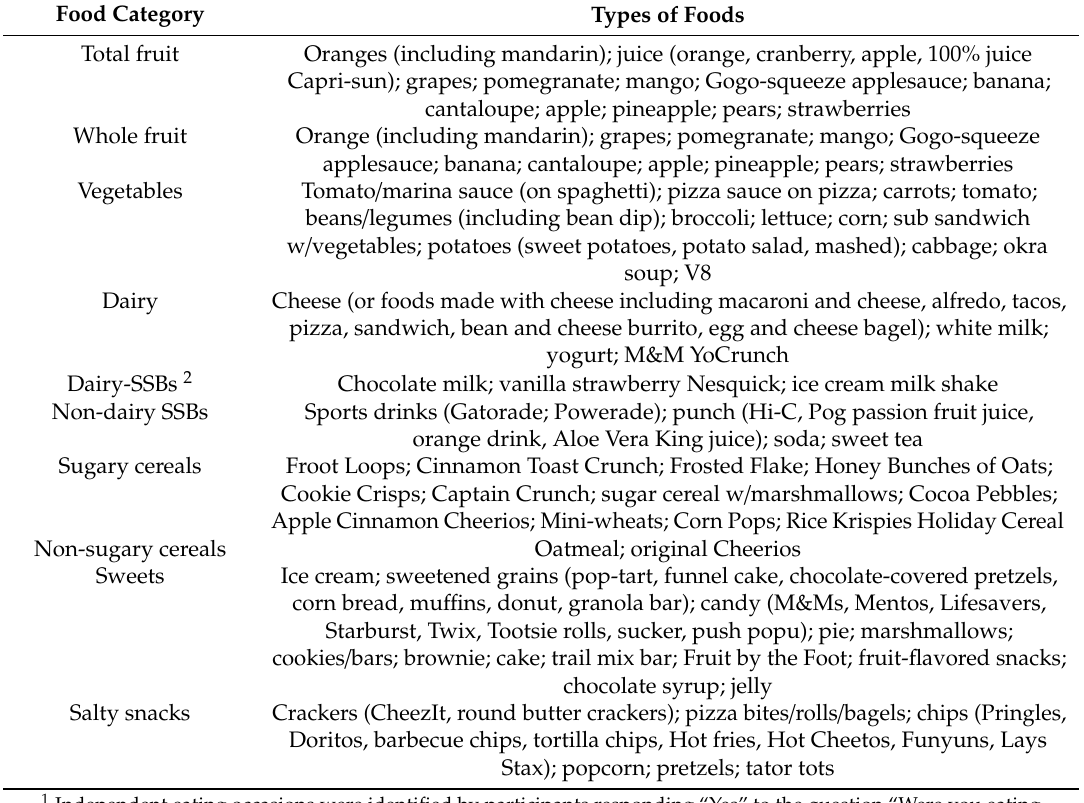
Table 1. Types of foods consumed at independent eating occasions (iEOs) among early adolescents aged 10–13 years 1